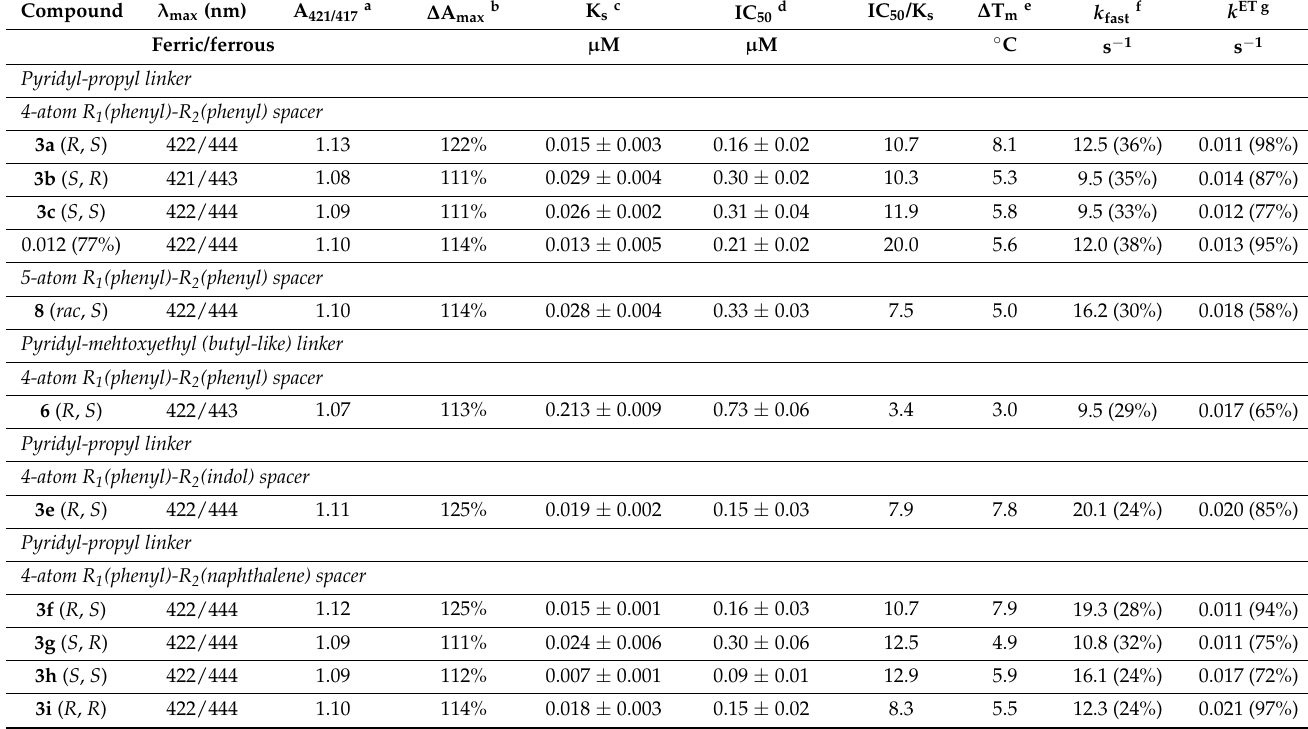
Table 1. Properties of series V